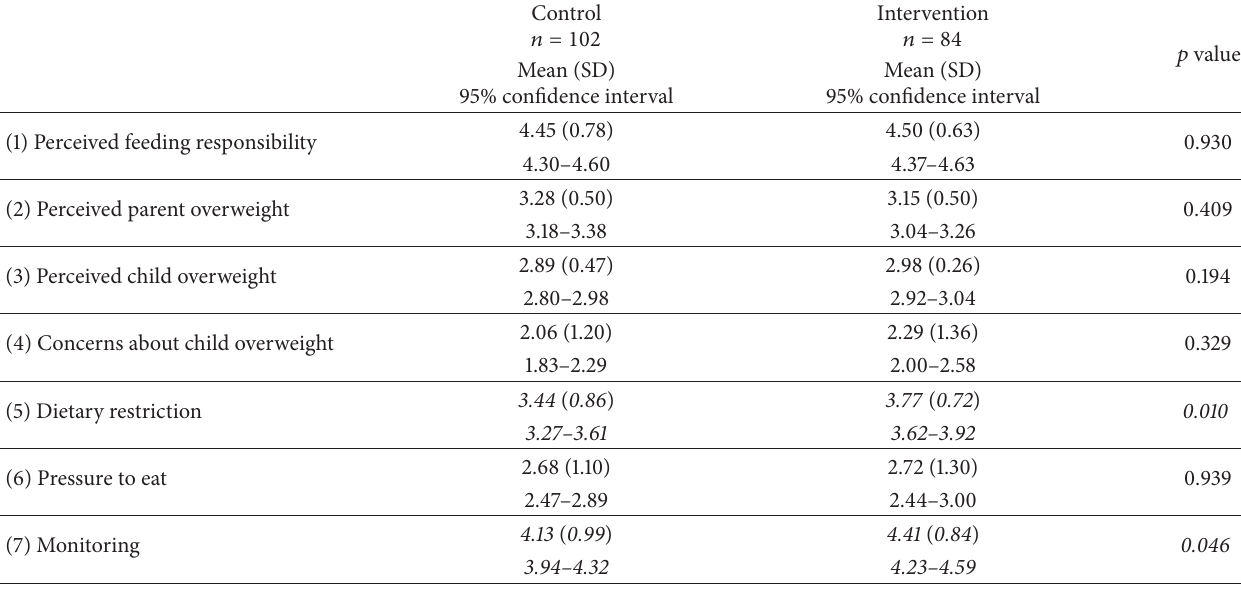
Table 2: Child Feeding Questionnaire Scores by control and intervention groups at 24